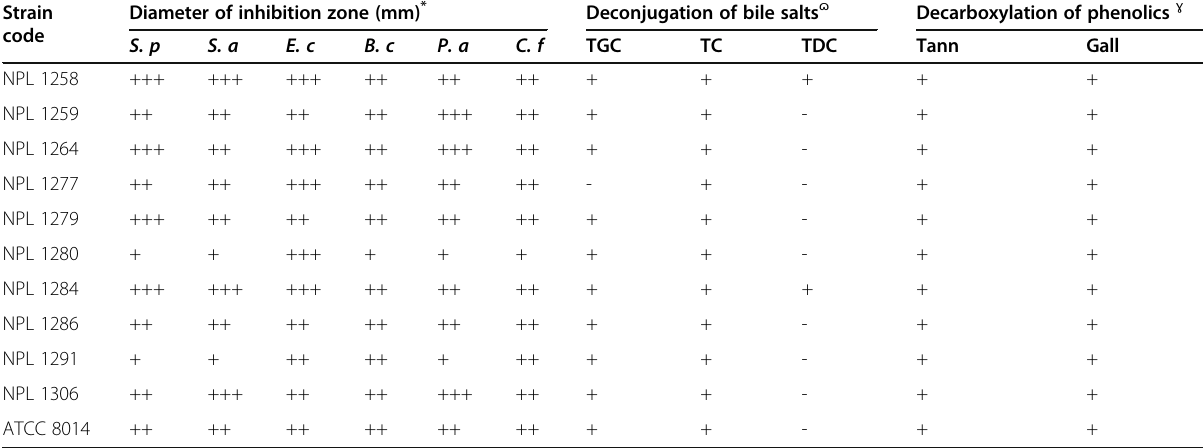
Table 4 Functional properties of selected LAB strains Strain code